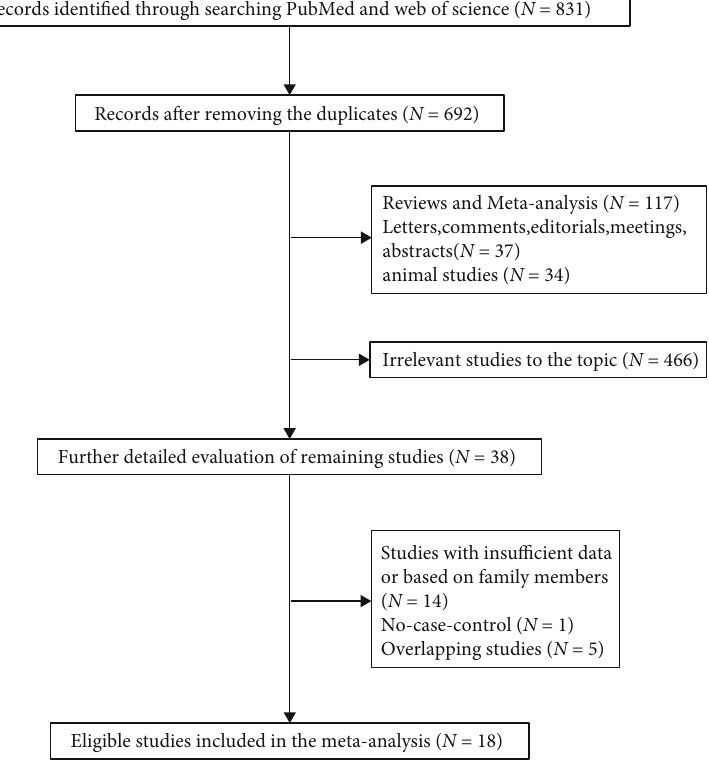
Figure 1: Flow chart for the literature search and screening in this